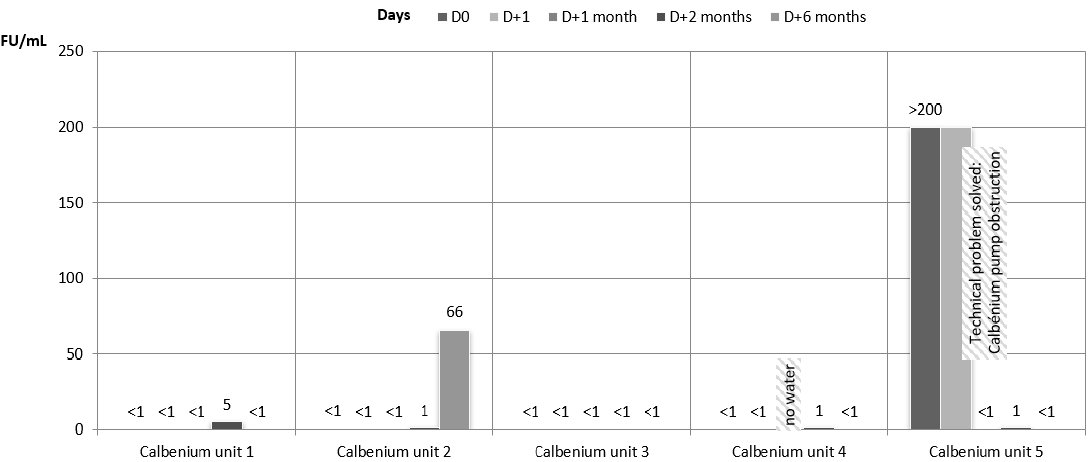
Figure 3. Microbiological quality of the water samples for the units connected to the Hygowater ® system. HPC at 22 °C.